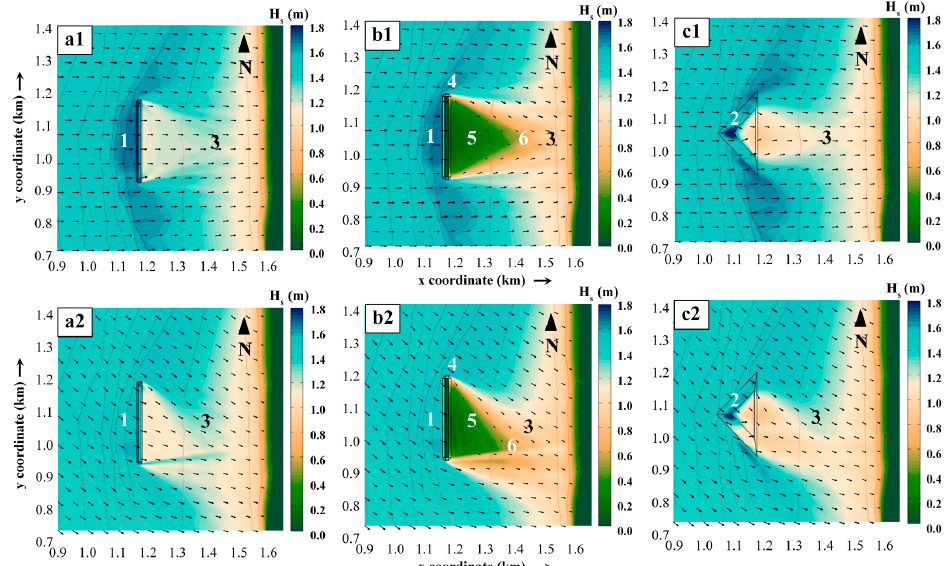
Figure 5. Significant wave height dissipation (arrows represent their mean direction) for frequent wave condition (SWAN model) for the west wave direction (upper panel): submerged detached breakwater ( a1 ), emerged detached breakwater ( b1 ), and MFAR ( c1 ); and for the northwest wave direction (lower panel): submerged detached breakwater ( a2 ), emerged detached breakwater ( b2 ), and MFAR ( c2 ). The indicated numbers relate to: 1—wave shoaling in the structure outward zone; 2—wave shoaling at the structure apex; 3—wave shoaling in the structure inward zone; 4—negligible 5—pronounced shadow zone; 6—significant wave height increase due to di ff raction. J. Mar. Sci. Eng. 2020 , 8 , 175